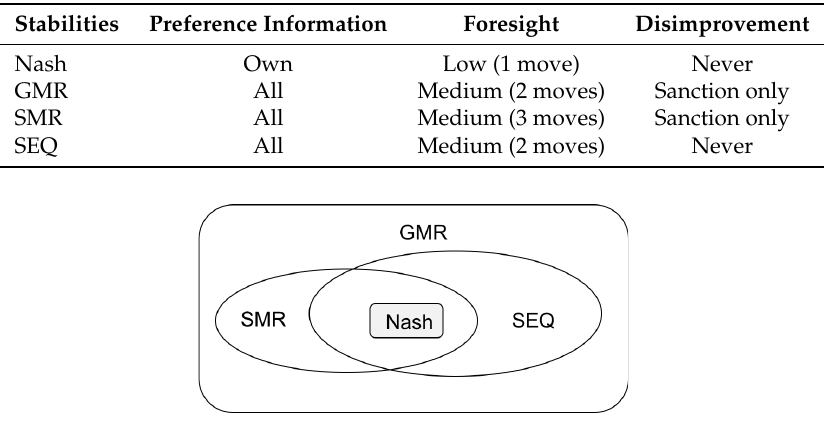
Figure 1. The relationships of the four stabilities.